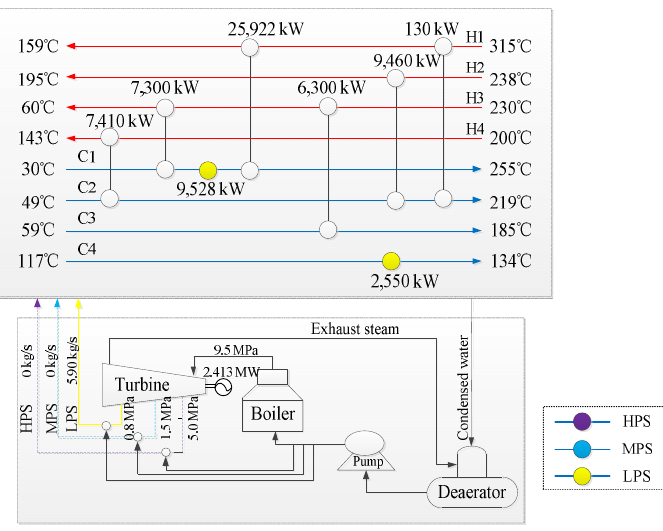
Figure 3. Structure with minimum TAC of Scenario 2.